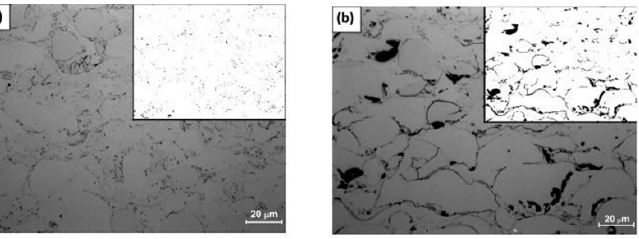
Figure 18. Cross-sectional structure of the as-sprayed coatings under different gas pressures ( a ) 4 and ( b ) 5 MPa. Reprinted with permission from [37] Copyright 2021 Elsevier .